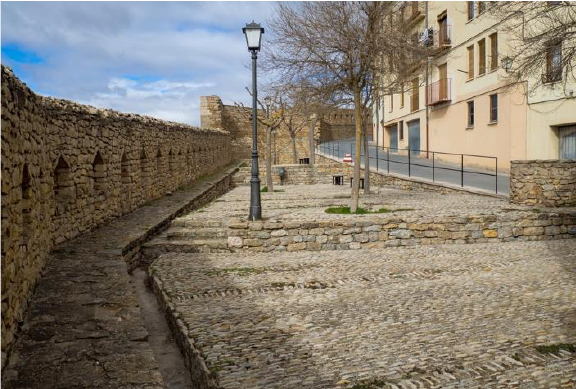
Figure 8. Urban area adjacent to the Torre del Carraixet (Source: S. Portela, 2018).